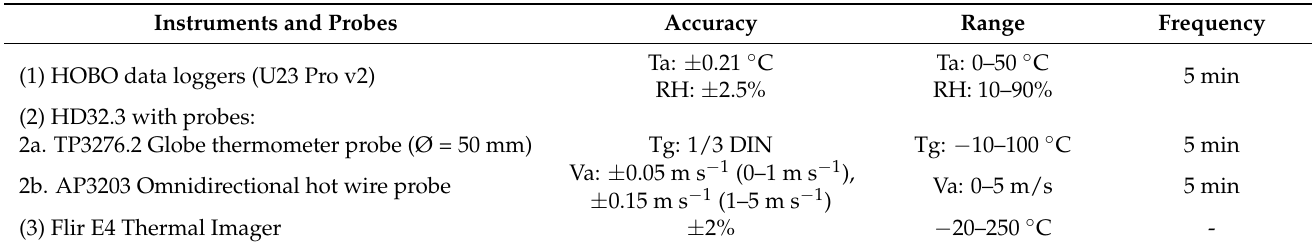
Table 3. Accuracy, range, and measurement frequency of the instruments and probes.